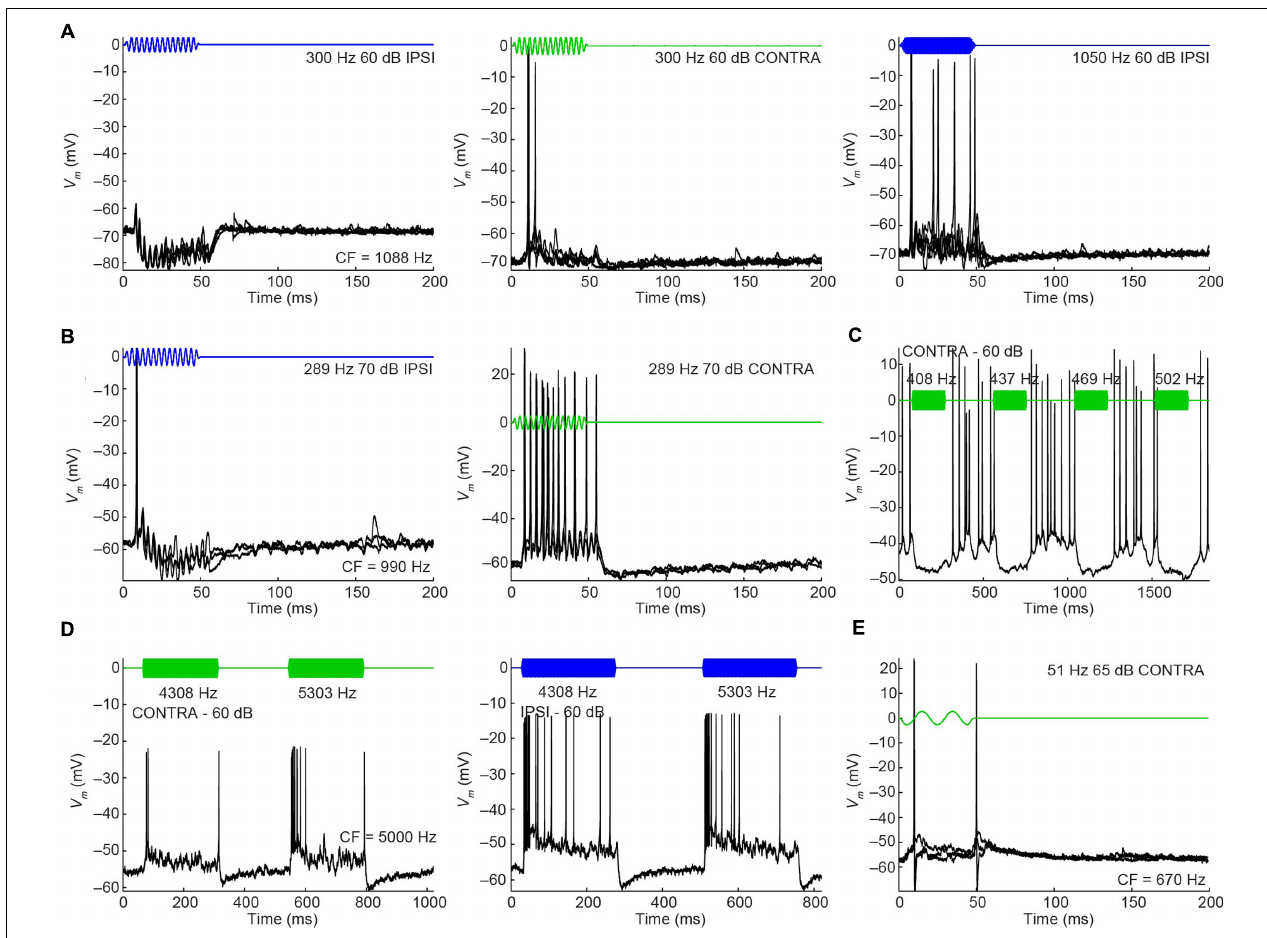
FIGURE 11 | Inhibitory features in responses to sound of mLNTB neurons. (A–E) Stacked responses to monaural stimuli for 5 mLNTB neurons. Stimuli are shown in blue (ipsilateral stimulation) or green (contralateral stimulation). Number of repetitions shown: (A) 5; (B) 3; (C) 1; (D) 1; (E)